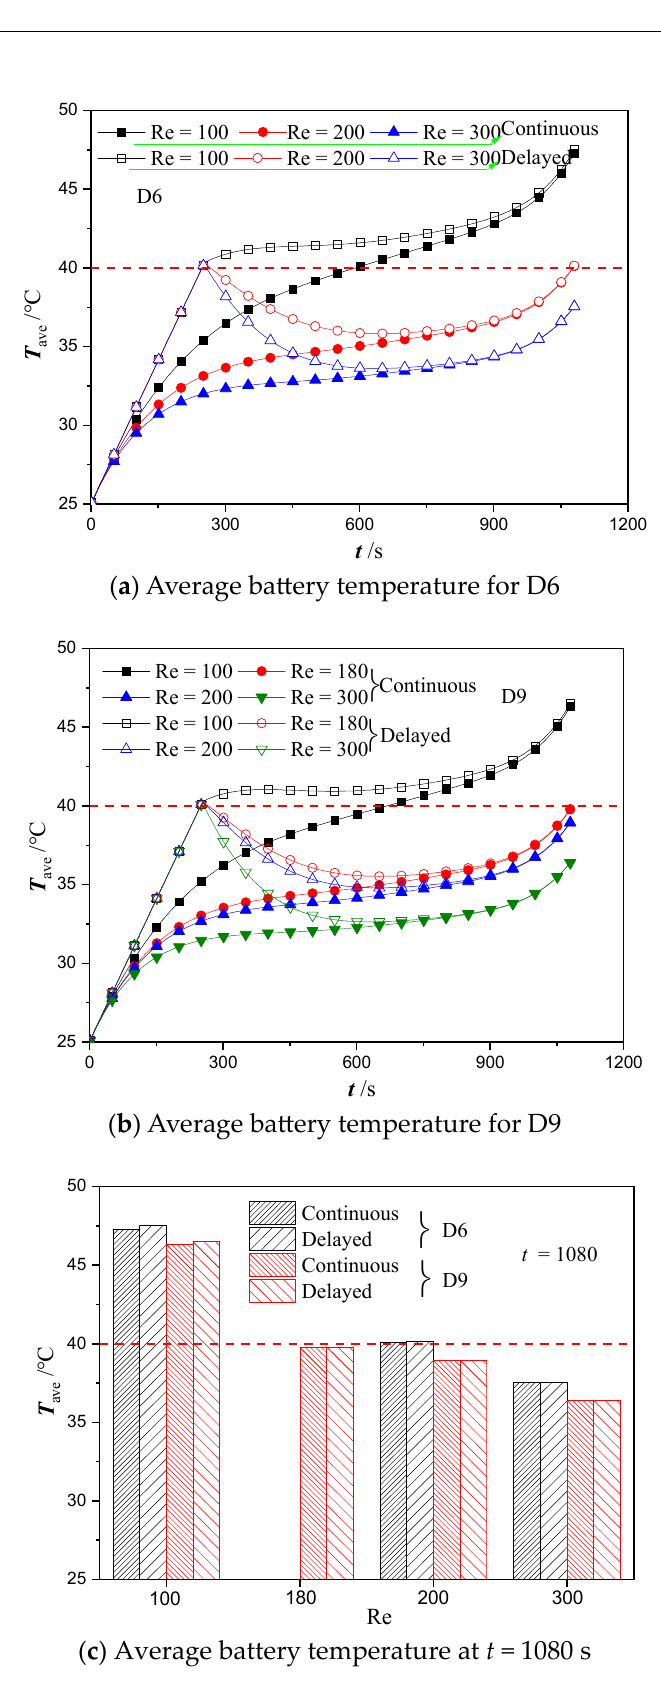
Figure 12. The change in the average temperature of battery for cold plate designs D6 and D9 between the two different cooling strategies: ( a ) D6; ( b ) D9; ( c ) at t = 1080 s.